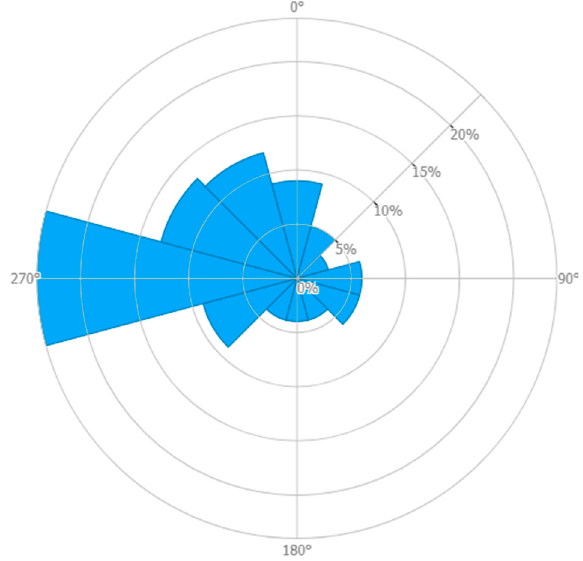
Figure 9 . Wind rose of Foveaux [16].